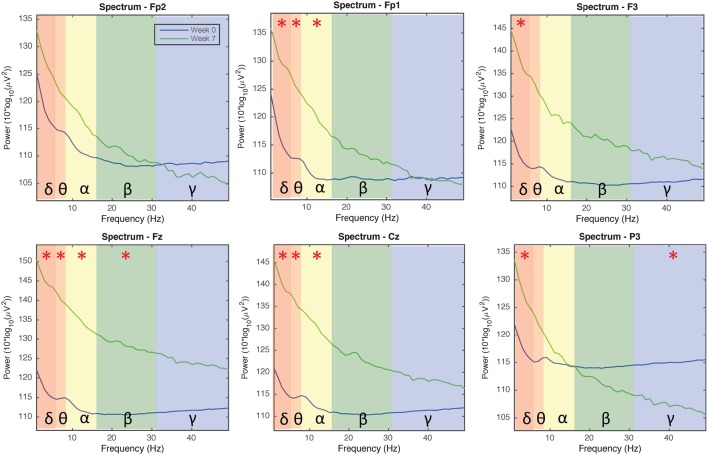
EEG power spectra analysis results comparison for all channels in the pre-study visit week and seventh week (1–50 Hz; Fp1, Fp2, Fz, F3, Cz, and P3). The background colors indicate the EEG frequency bands: red, δ wave; orange, θ wave; yellow, α wave; green, β wave; blue, γ wave. The green lines and blue lines, respectively, indicate power spectra in the seventh week and pre-visit week of tDCS stimulation. Generally the power of δ, θ, α, and β waves increased, while the power of γ wave decreased in channels Fp1/Fp2/P3 and increased in channels F3/Fz/Cz, after 7 weeks of tDCS stimulation.